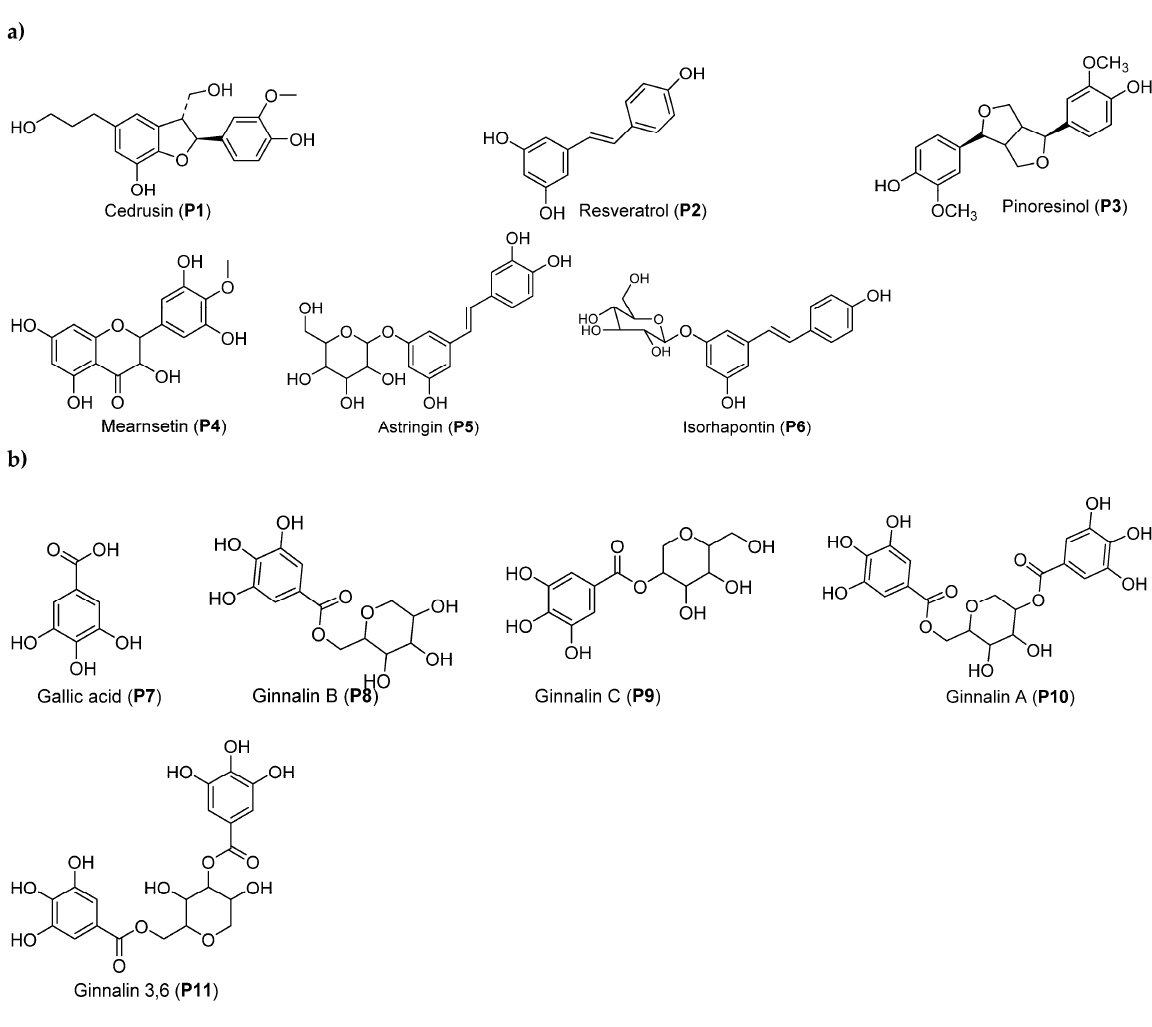
Figure 2. Main molecules identified in promising extracts from bark of black spruce ( Picea mariana ) ( a ) and red maple ( Acer rubrum ) ( b ).